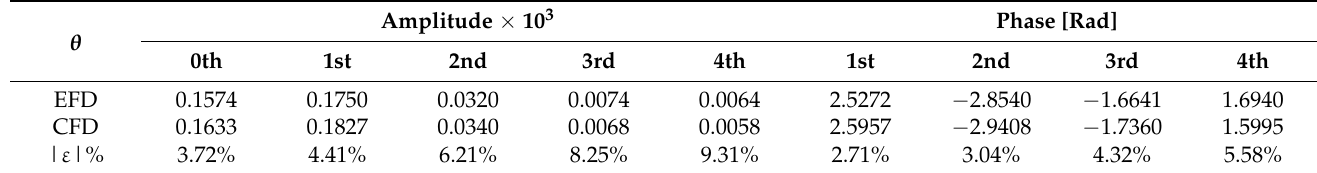
Table 28. Harmonic amplitudes and phases of pitch for the FRxz ϕθ following waves